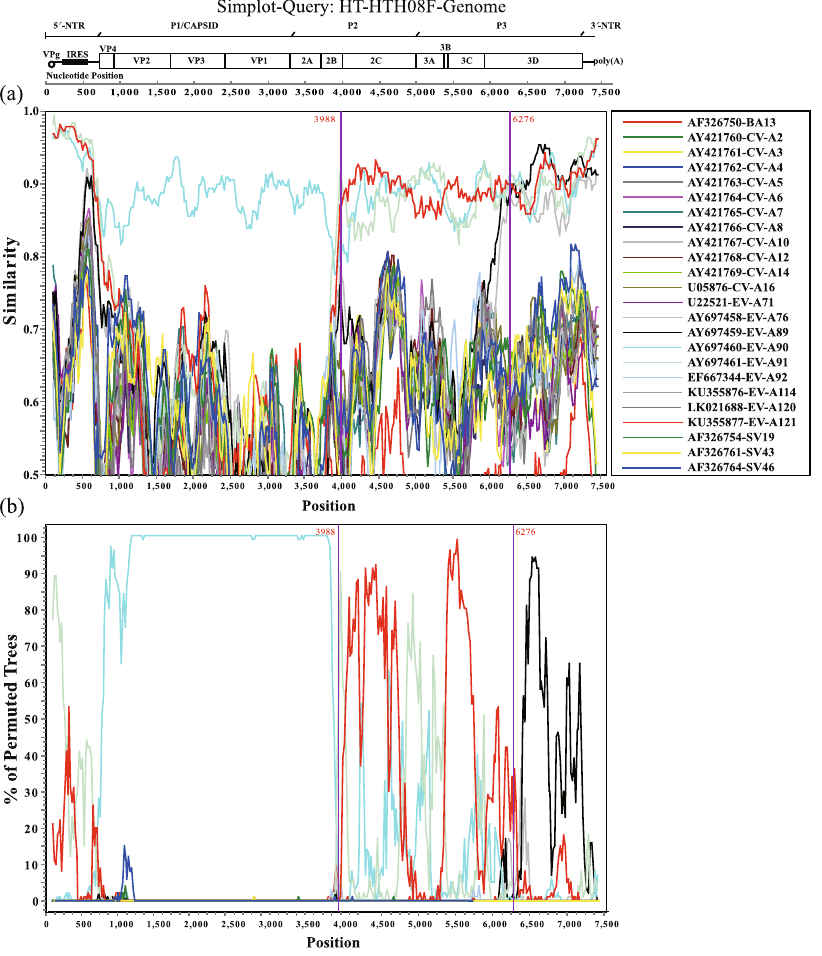
Figure 2. Potential recombination analysis of the whole genome of the Xinjiang EV-A90 strains. Similarity analysis ( a ) and bootscaning analysis ( b ) were performed in a 200-nt sliding window. Each point indicated similarity between the Xinjiang strain and other EV-A strains in a 20-nt moving step. Kimura (2-parameter) model was used in the